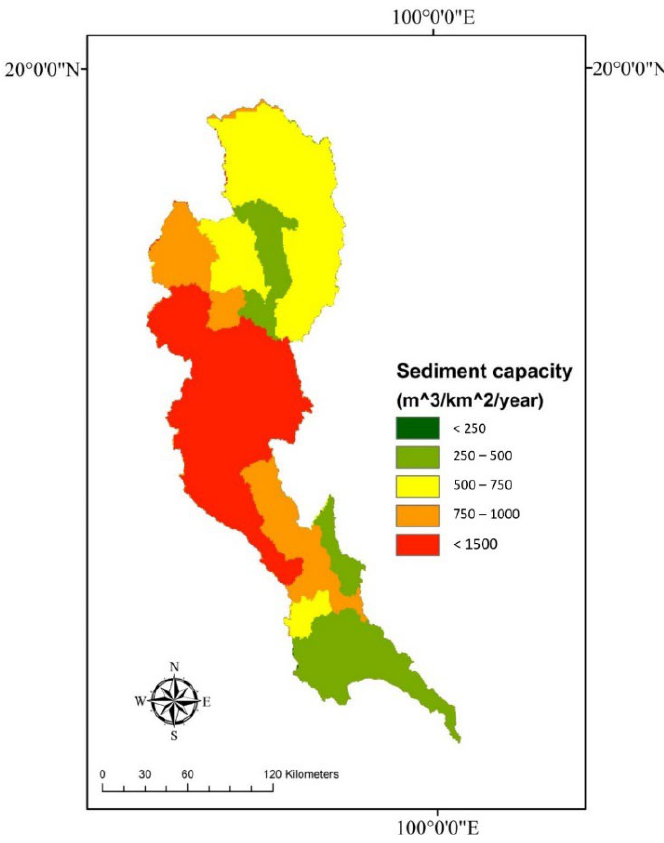
Figure 10. Potential of sediment capacity.